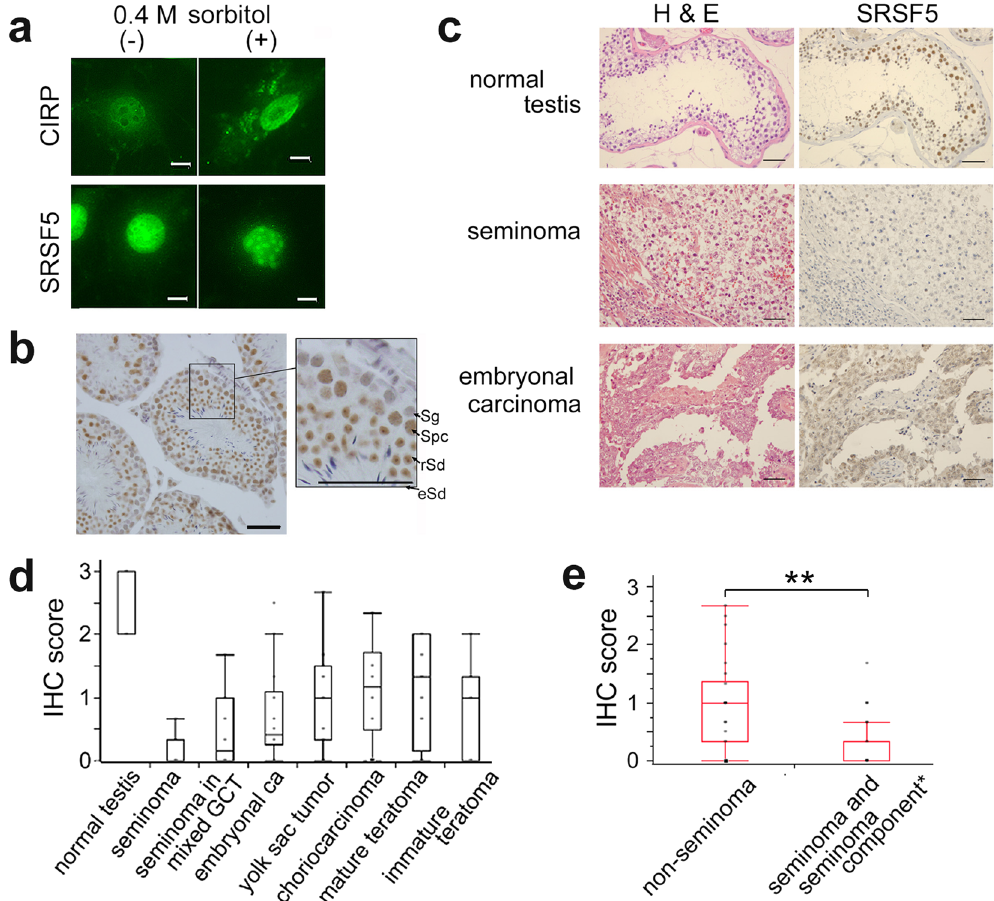
Figure 2. Subcellular localization and testicular expression of SRSF5 protein. ( a ) Localization of SRSF5 and CIRP proteins detected by immunofluorescence microscopy in NIH/3T3 cells cultured in PBS with ( + ) or without ( − ) 0.4 M sorbitol at 37 °C for 2 h. Scale bars, 50 μ m. ( b ) Immunohistochemical (IHC) detection of SRSF5 protein in the testis of 6-wk-old C57BL/6 J mouse. Square region was enlarged in the right panel. Sg, spermatogonia; Spc, spermatocytes; rSd, round spermatids; eSd, elongated spermatids. Scale bars, 50 μ m. ( c ) Hematoxylin and eosin (H&E) staining and IHC staining for SRSF5 of human normal testis and testicular germ cell tumors. Representative results are shown. Scale bars, 50 μ m. ( d ) IHC scoring of SRSF5 protein levels in human normal testes and germ cell tumors (data indicate mean ± SEM. See Methods for the numbers of samples). ( e ) IHC comparison of SRSF5 protein levels between non-seminomas (n = 19) and seminoma components of mixed tumors and pure seminomas (n = 30) (data indicate mean ± SEM). Statistical significance was determined by Student’s t -test. ** , P <